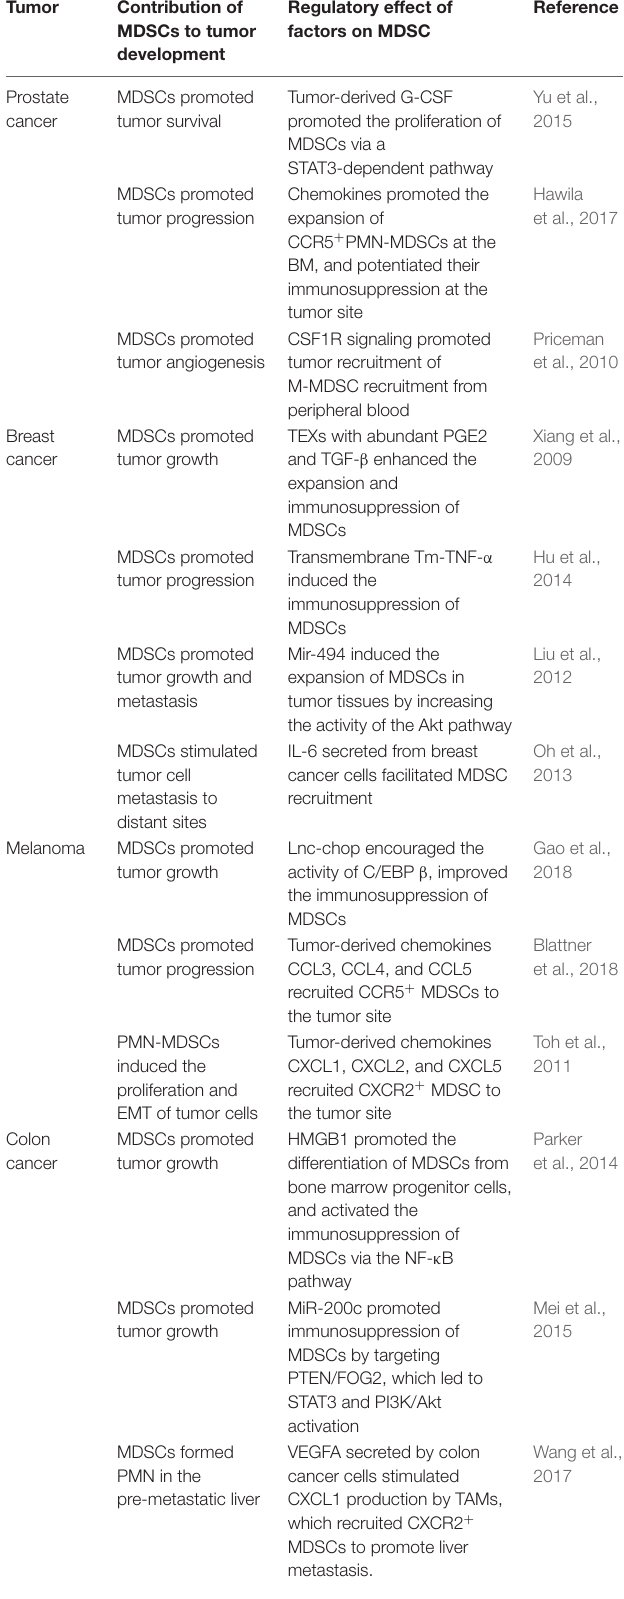
TABLE 1 | Myeloid-derived suppressor cells in a variety of